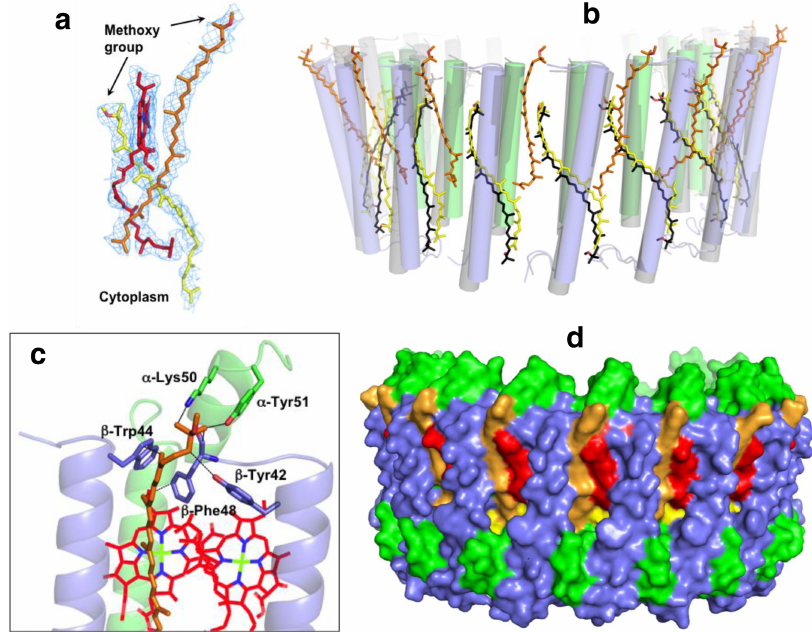
Fig. 4 Carotenoids in the Rba. sphaeroides LH1. a Typical structures and density maps (3 σ ) of two spheroidenes (yellow and orange) relative to the position of a BChl a (red) in the LH1 complex with different con fi gurations. b Two groups of the spheroidenes (yellow and orange sticks for Group-A and Group-B, respectively) in the Rba. sphaeroides LH1 in comparison with the carotenoids in the Tch. tepidum LH1 (black sticks, PDB:5Y5S). The structures were superimposed by C α carbons of the LH1 αβ -polypeptides between Rba. sphaeroides (transparent green and slate-blue cylinders) and Tch. tepidum (transparent gray cylinders). c Close contacts (<4.0 Å, dashed lines) between a Group-B spheroidene and its surrounding αβ -polypeptides. d Side view of the surface representation shows a sealed fence for the Rba. sphaeroides LH1 complex. Color scheme: LH1- α , green; LH1- β , slate-blue; BChl a , red; spheroidenes, yellow (Group-A) and orange